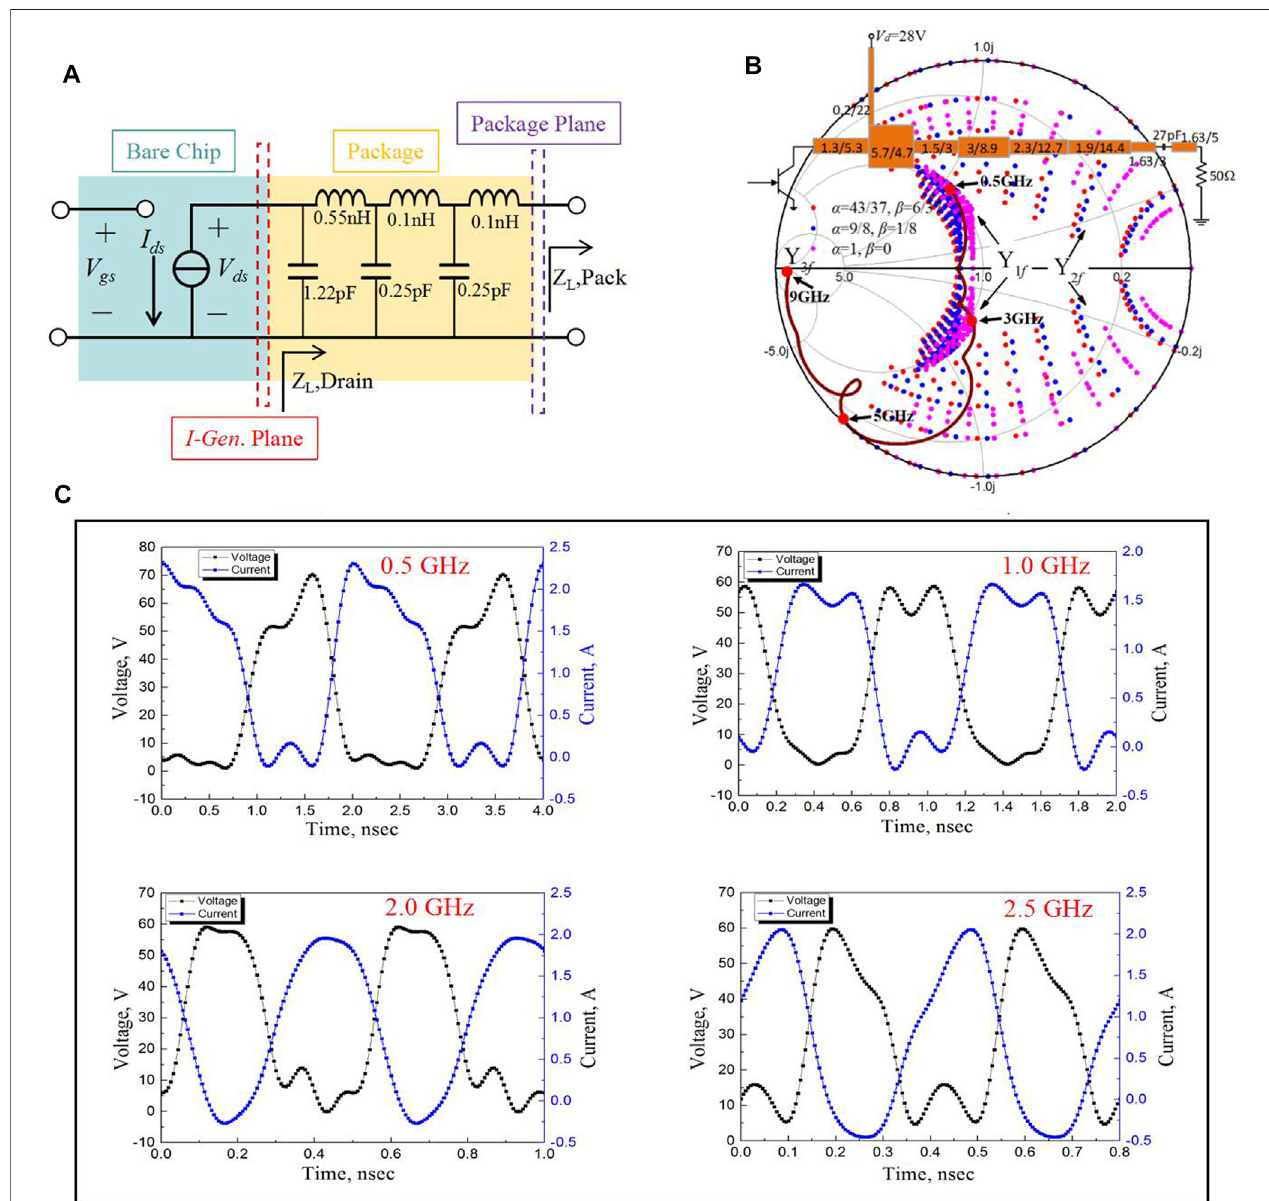
FIGURE2|(A) Equivalentcircuitmodeloftransistormodelingshowingtheparasitics. (B) Outputmatchingnetworkandtheadmittancesattheintrinsicdrainplane. (C) De-embedded voltage and current waveforms of the PA at the I-gen plane.